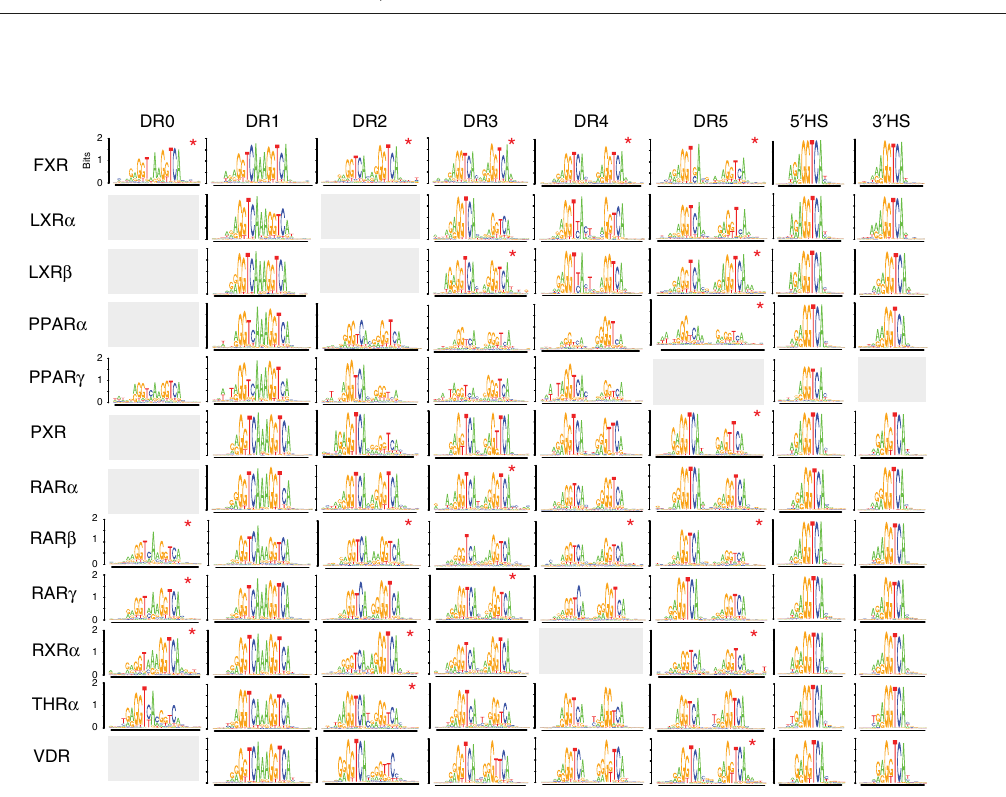
Fig. 1 Characterizing NR-DNA binding with PBMs. a Schematic of spacer preferences for NRs to direct repeats (DRs) and half-sites (HS). b Canonical spacer preferences of NRs indicate preferred spacer lengths from the literature (Supplementary Data 2 and 3). Published PWM models are shown in colored dots that indicate the methodology used to derive the model (Supplementary Data 3). c Schematic of PBM probes, SNV probe organization and SNV-based motif generation for a single seed sequence. d Scatter plot of z-scores for RAR β :RXR α experiments detected with antibodies against each heterodimer partner. Dots represent average over ~5 replicates for all 10,728 unique SNV probes (black dots) and 500 background probes (gray dots) e PBM replicate averaged z-score distributions for PPAR γ :RXR α to all SNV probes. Z-scores for consensus DR1 and reported functional binding sites are highlighted (Supplementary Data 2) 6 . f DR1 DNA-binding logo for PPAR γ :RXR α generated from all DR1 full-site models from the PBM experiments. g Comparison of PPAR γ :RXR α PBM z-scores and competition EMSA-determined relative K d measurements for binding sites spanning a wide af fi nity range. Relative K d values are normalized to the highest af fi nity sequence (P1) and represent mean over two independent experiments (error bars = STDEV). Identi fi able DR half-sites in each binding sequence are shown in bold. Mutations introduced to ablate the 5 ’ half-site of P3 (P3 5 ’ Abl) or the 3 ’ half-site of P3 (P3 3 ’ Abl) are shown in red. Source data are provided as a Source Data fi le